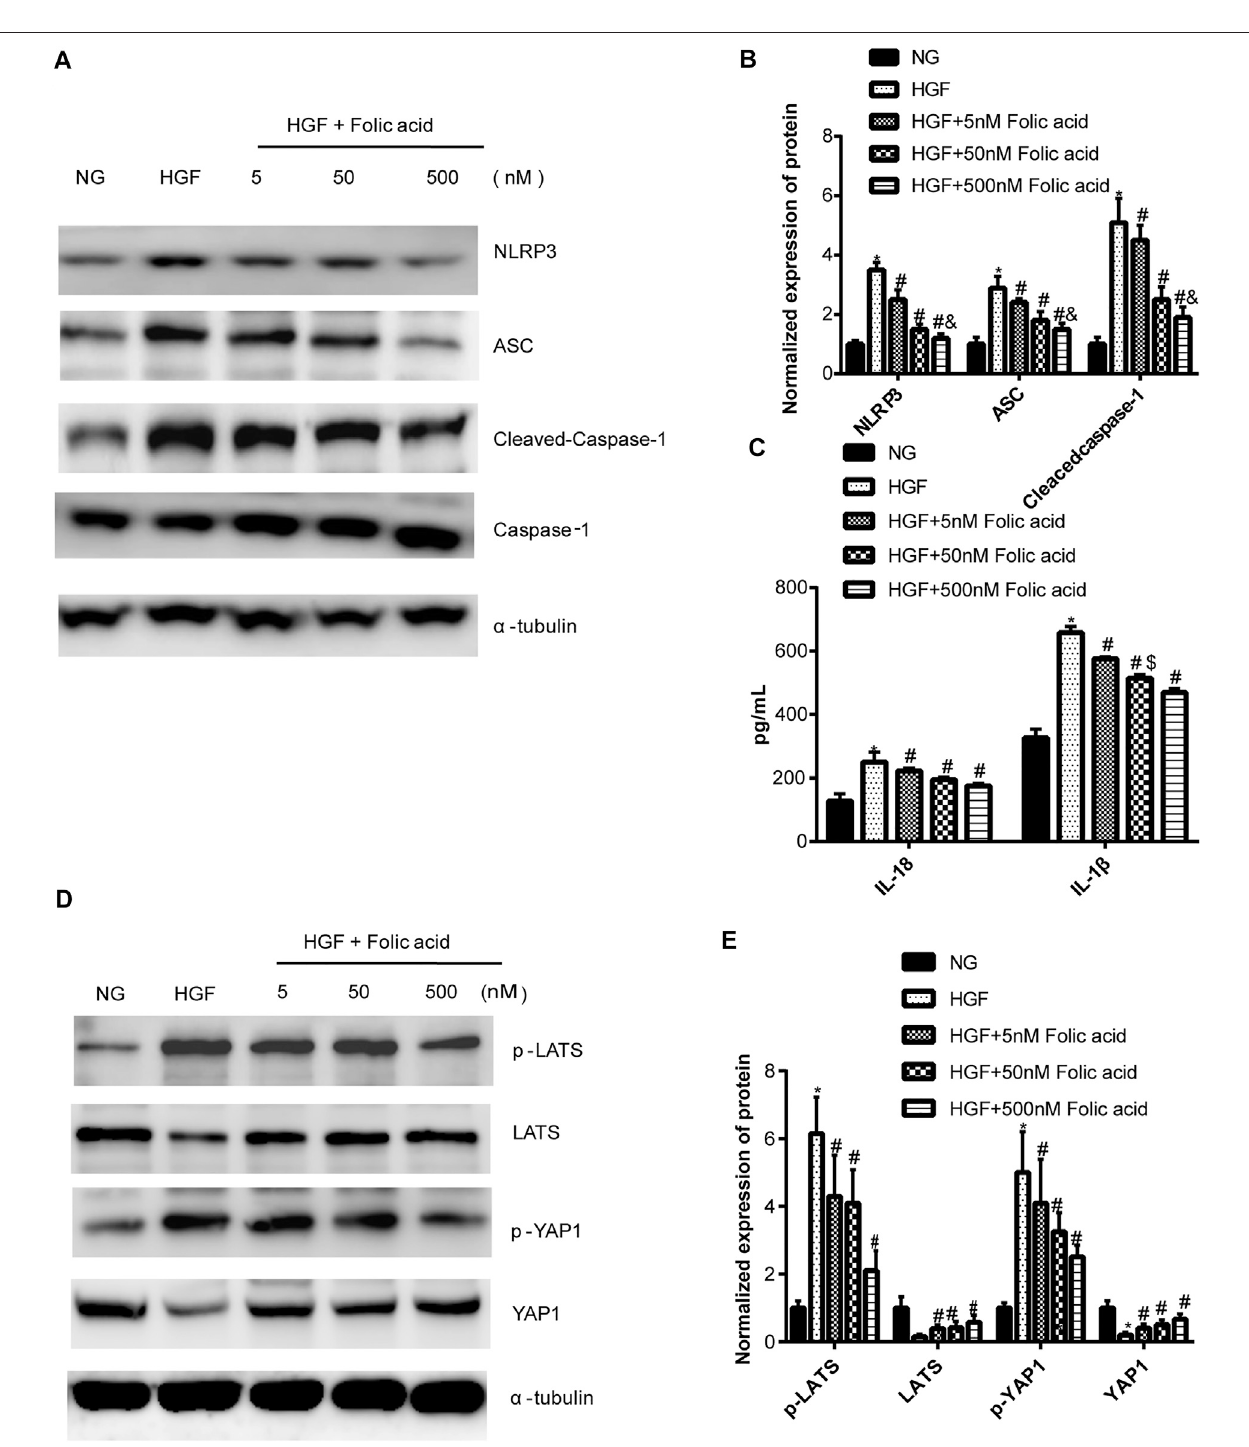
FIGURE4| EffectoffolicacidonthepyroptosisandHipposignalingpathway. (A) RepresentativeimmunoblotshowingexpressionlevelsofNLRP3,ACS,Cleaved- Caspase-1andCaspase-1. (B) Quanti fi cationofNLRP3,ACS,Cleaved-Caspase-1andCaspase-1with α -tubulinastheloadingcontrol. (C) IL-1 β andIL-18levelsinthe cell supernatant. (D) Representative immunoblot showing expression levels of YAP1 and p-YAP1. (E) Quanti fi cation of YAP1 and p-YAP1 with α -tubulin as the loading control. * p < 0.05, compared with NG; # p < 0.05, compared with HGF; & p < 0.05, compared with HGF+50 nM folic acid.